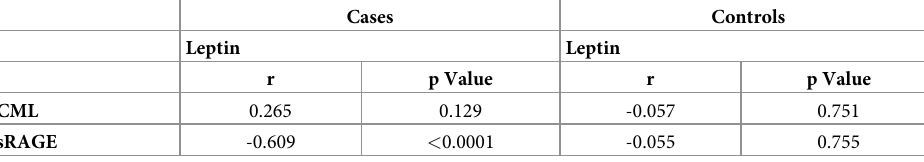
Table 2. Bivariate correlations with leptin, CML and sRAGE in patients with TB and controls. Cases